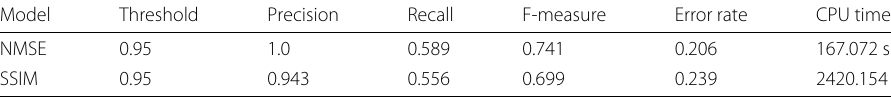
Table 2 Model comparison between image preprocessing models Model